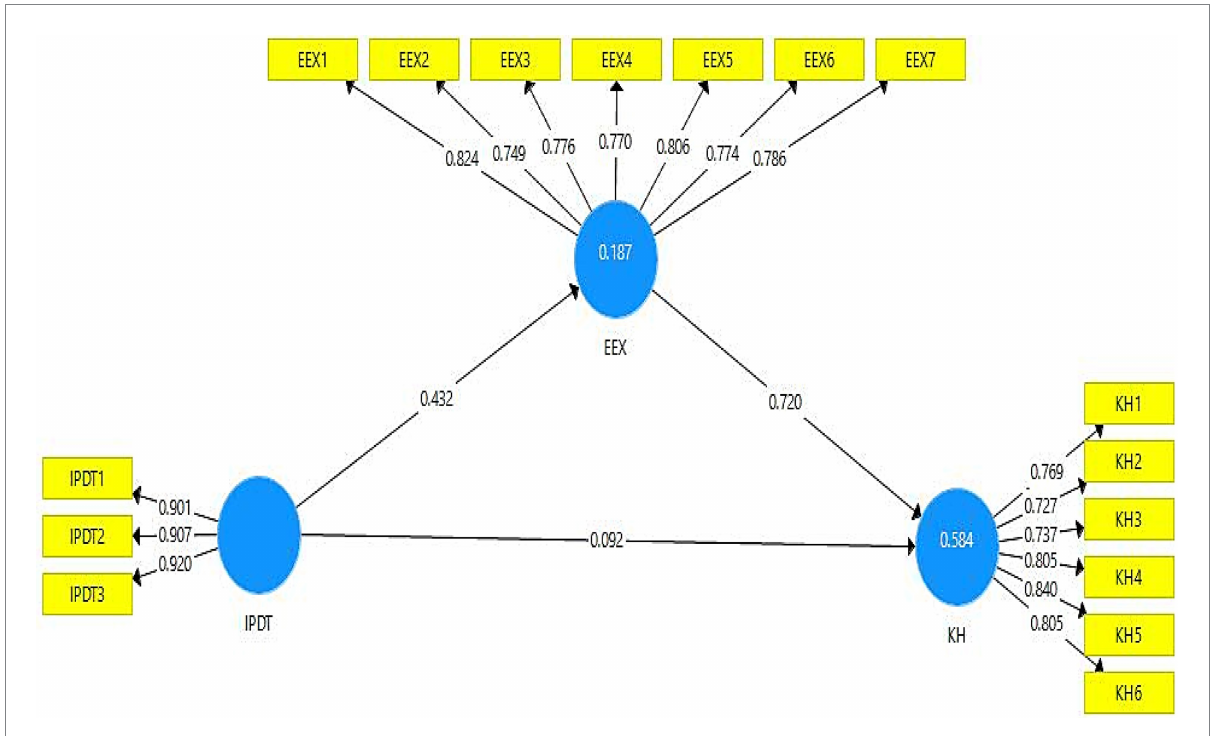
FIGURE 2 Path estimates